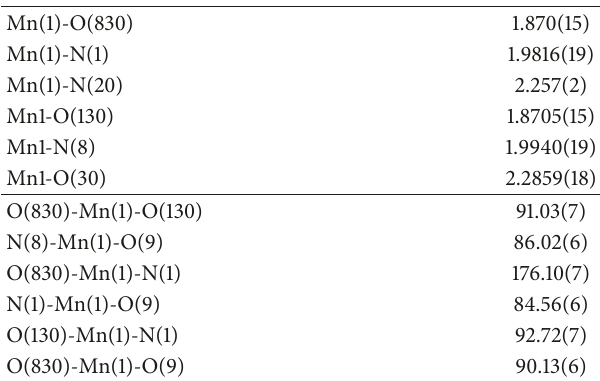
− 15.0 Figure 4: Paramagnetic 1 H NMR spectrum for complex 2 . Table 4: Selected bond lengths (˚A) and angles ( ∘ ) for complex 1 . Figure 5: ORTEP representation (50% probability) of H